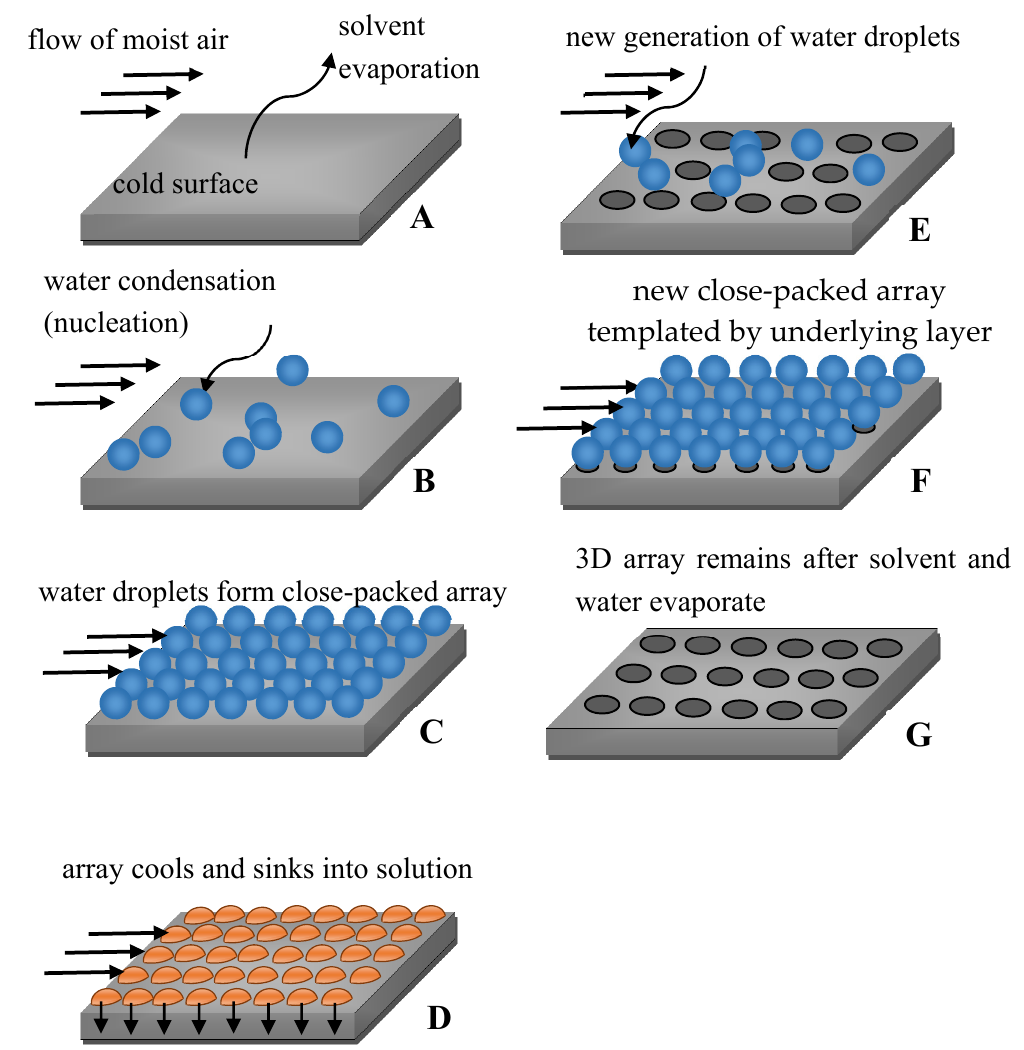
Figure 1. Sequence of stages resulting in breath-figure self-assembly. ( A – D ) formation of the first row of pores; ( E – G ) Formation of the second row of pores.